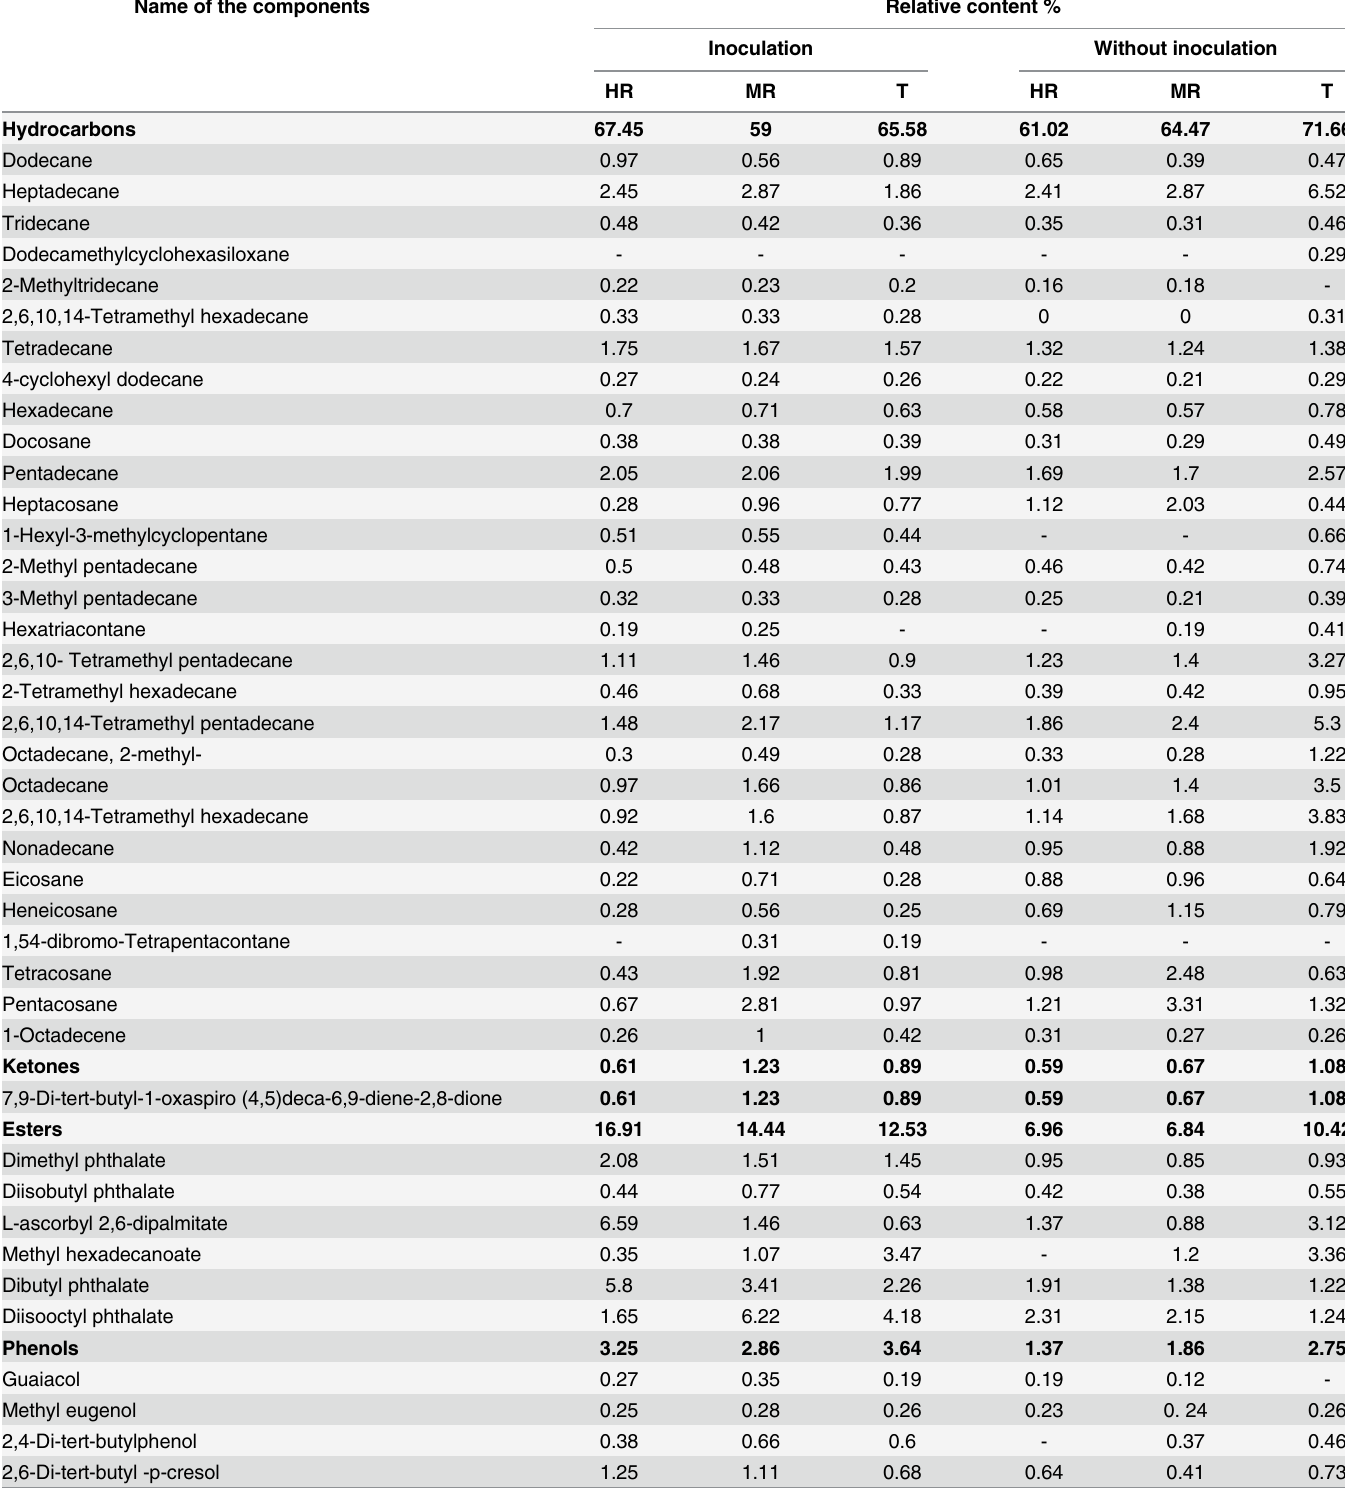
Table 2. Component identified from tomato plant root exudates. Name of the